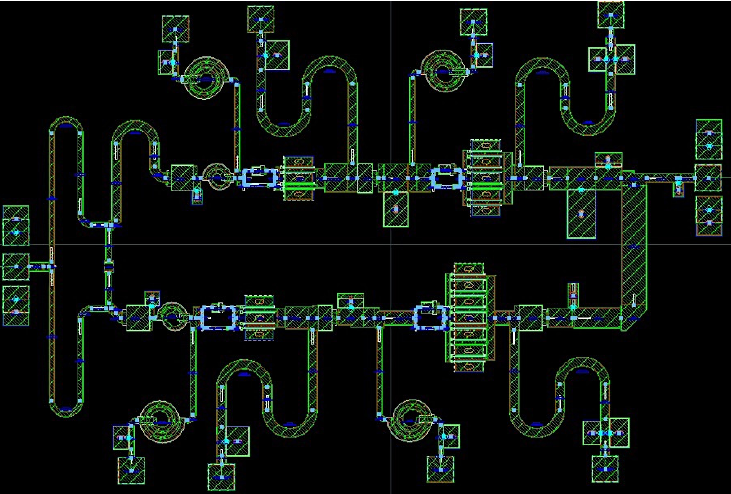
Figure 6. Layout of the designed monolithic IC DPA with the size area of 2.3 mm × 1.4 mm.